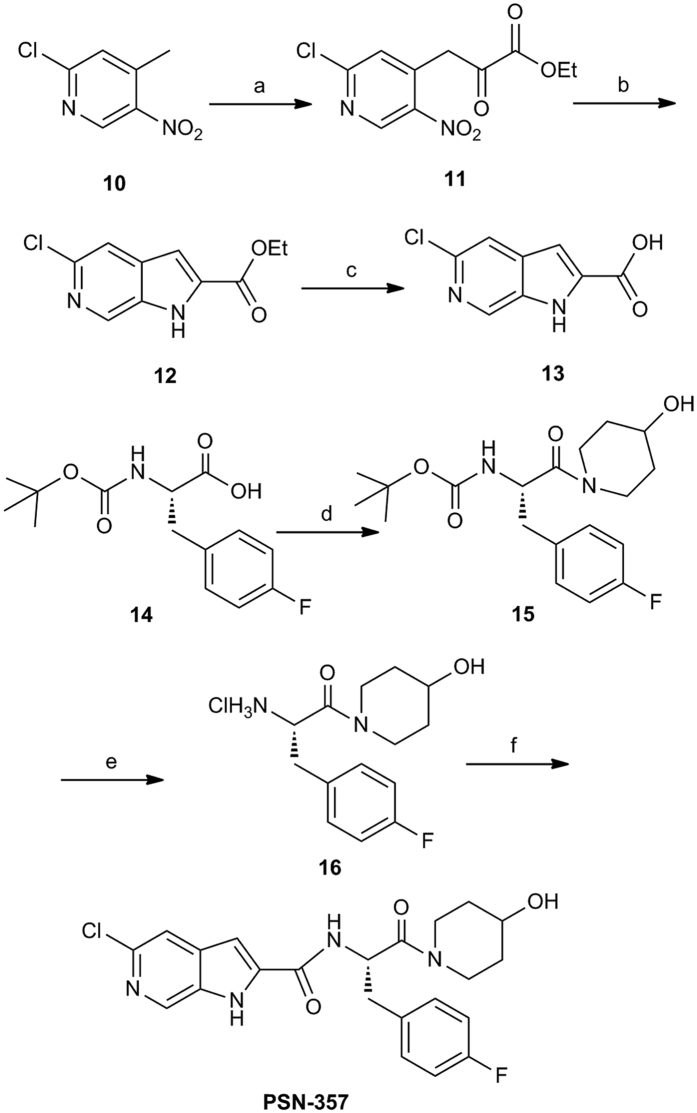
Synthesis of PSN-357a.Reagents and conditions: (a) Diethyl oxalate, C2H5OK, CH3OH/(C2H5)2O, rt; (b) Fe, NH4Cl, C2H5OH/THF, reflux, 32%; (c) NaOH, C2H5OH, reflux, 83%; (d) 4-hydroxypiperidine, HATU, DIPEA, anhydrous CH2Cl2, 0 °C to rt, 98%; (e) HCl/CH2Cl2, 0 °C to rt, 89%; (f) 13, HATU, DIPEA, CH2Cl2, 0 °C to rt, 69%.